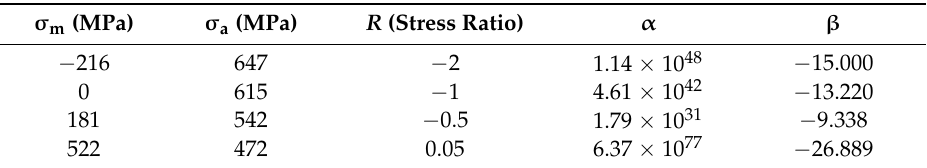
Table 3. Obtained fatigue strengths at 2 × 10 6 cycles for the different stress ratios together with the α and β Basquin parameters of the inclined part of the S - N curves.